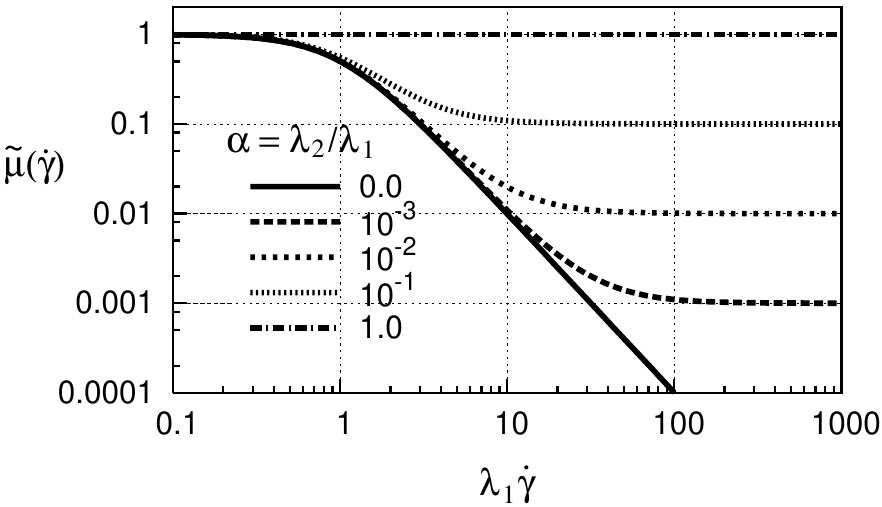
Figure 3. Viscosity dependence on shear-rate ˙ γ and parameter α . The role of parameters λ 1 and a is slightly more difficult to identify. In Formula (15) these parameters appear together in the term product could be obtained by fitting the expression (15) against some simple-shear viscosity data. The graph of this joint parameter λ 1 is shown in Figure